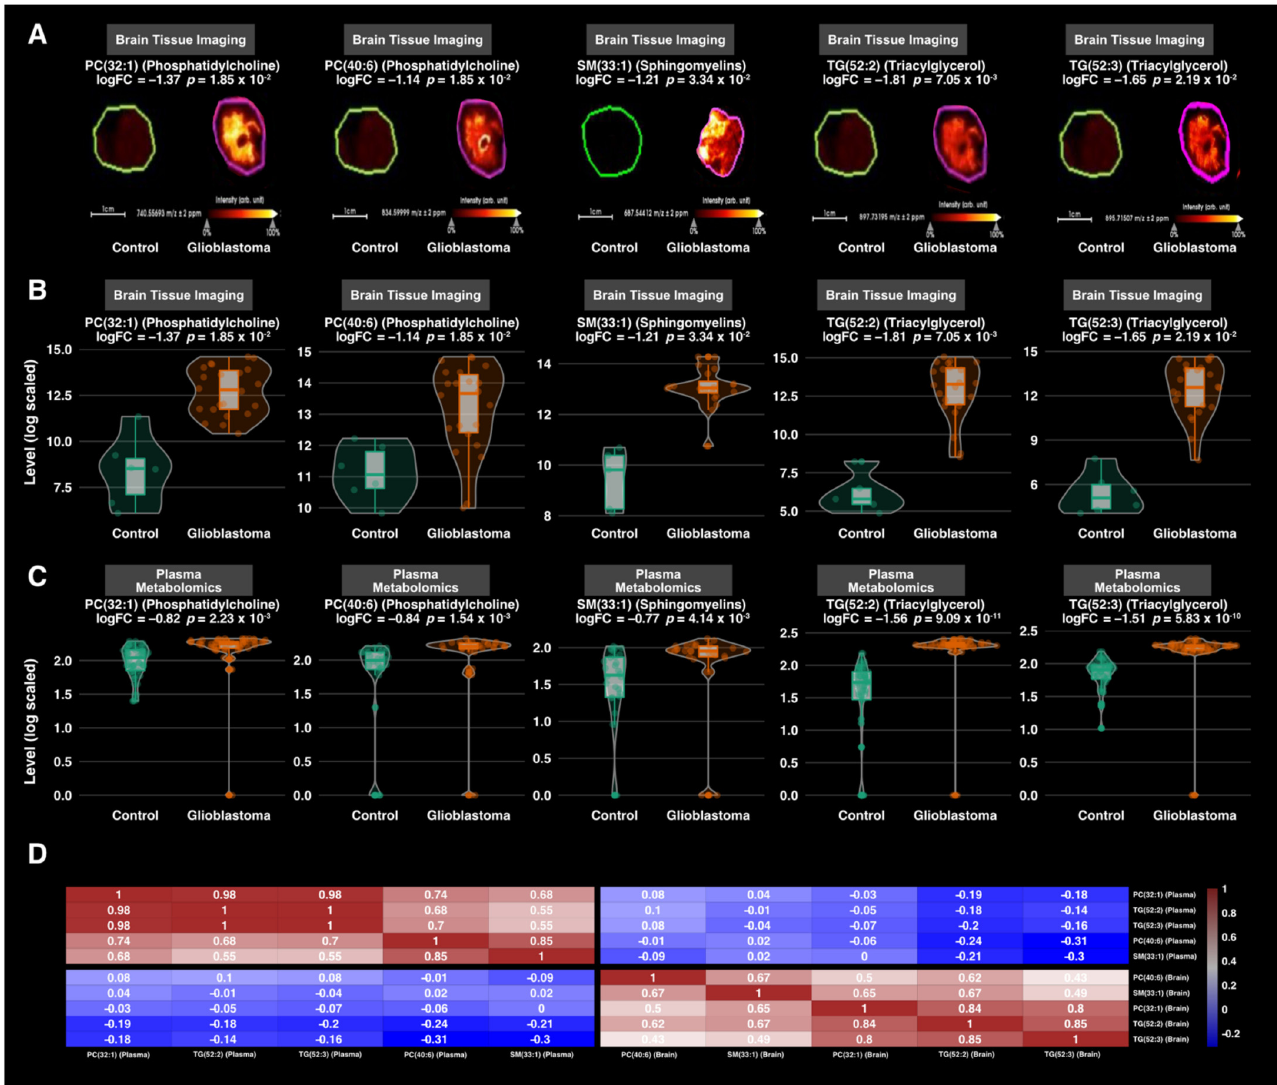
Figure 5. Overlap analysis between tissue-based and plasma-based metabolomics results. ( A ) Brain tissue section distribu- tion of selected overlap lipids. Ion images were generated using SCiLs Lab software. ( B ) Brain tissue sections boxplots of the selected top five differentially expressed metabolites among the overlap lipids with related adjusted p -values. The y -axis shows the log-scaled average intensity. ( C ) Plasma boxplots of the selected top five differentially expressed lipids among the overlap metabolites with related adjusted p -values. The y -axis shows the log-scaled intensity. ( D ) Spearman correlation analysis between the selected top five lipids that overlap between tissue-based and plasma-based metabolomics